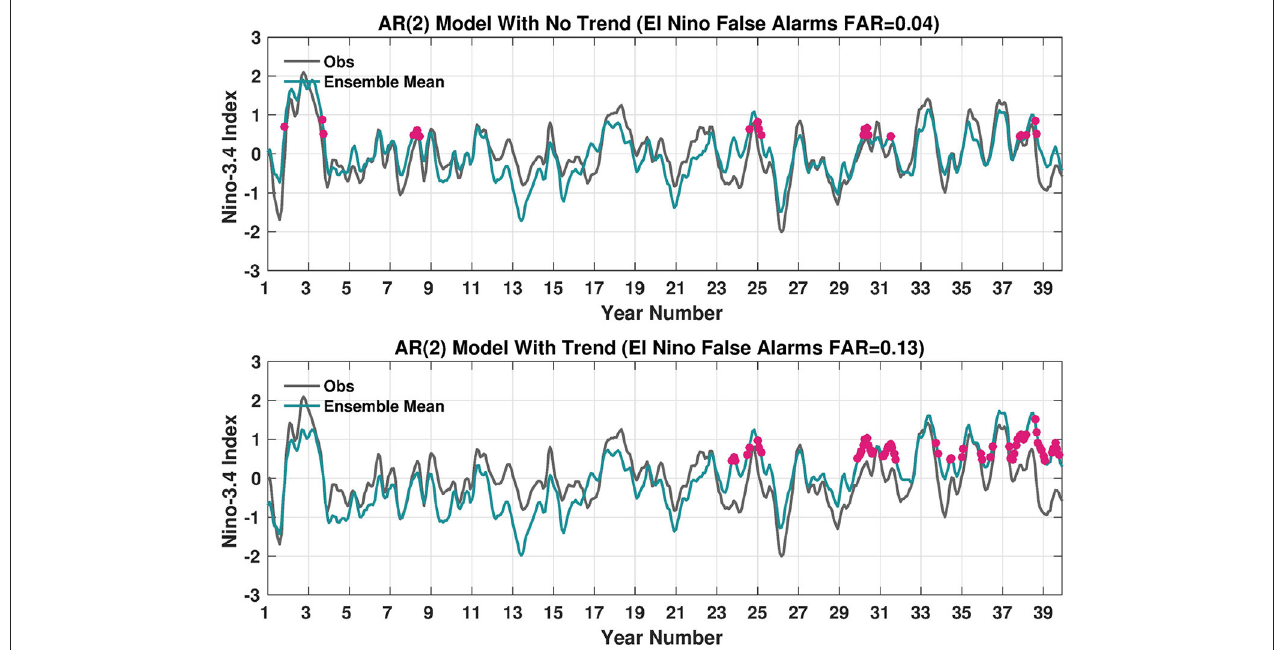
FIGURE 10 | AR(2) Ensemble Mean Model Simulation of the Niño3.4 SST index (blue line) shown with no linear trend (Top) and with a linear trend that matches the trend in FLOR-A for lead = 8.5 (Bottom) . The gray line, or observational proxy, is a single member from the 100-member simulation. Pink dots show the occurrence of El Niño False Alarms or cases when the Niño3.4 index prediction is in excess of 0.45 ◦ C, but the observations are less than this threshold. The simulation is in units of degrees